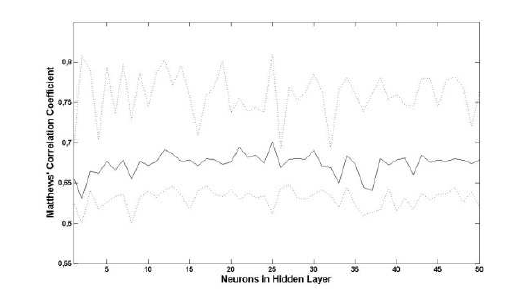
Fig. 2. NN Matthews’ correlation coefficient in experiment